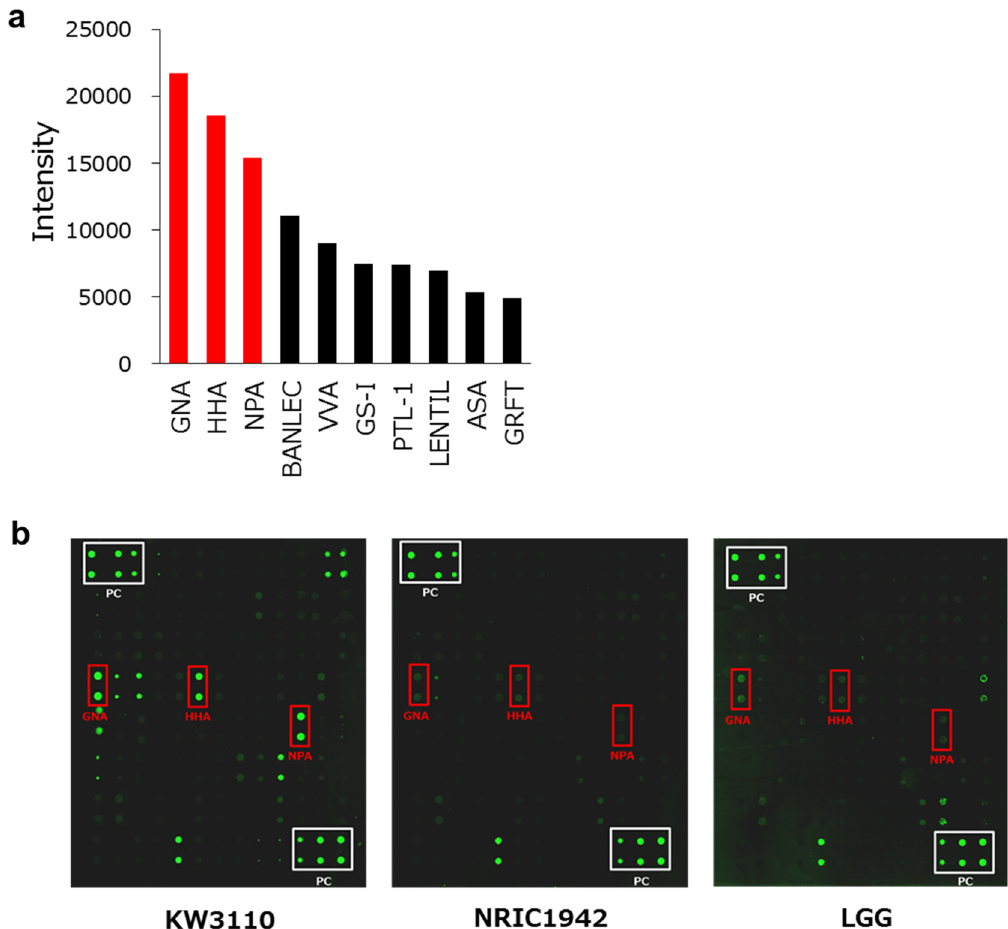
Figure 6. The patterns of lectin-binding affinity differ between the strains of LAB. ( a ) Fluorescence detection images of lectin arrays. Spots enclosed within a white line indicate positive control. The three lectins enclosed within a red line are described in abbreviation, GNA; Galanthus nivalis bulbs, HHA; Hippeastrum hybrid bulbs, NPA; Narcissus pseudonarcissus bulbs. ( b ) The 10 highest intensity lectin array spots after KW3110 addition; top 3 are represented in red. All lectins named are described in abbreviation, GNA Galanthus nivalis bulbs, HHA Hippeastrum hybrid bulbs, NPA Narcissus pseudonarcissus bulbs, BANLEC E. coli expressed Musa